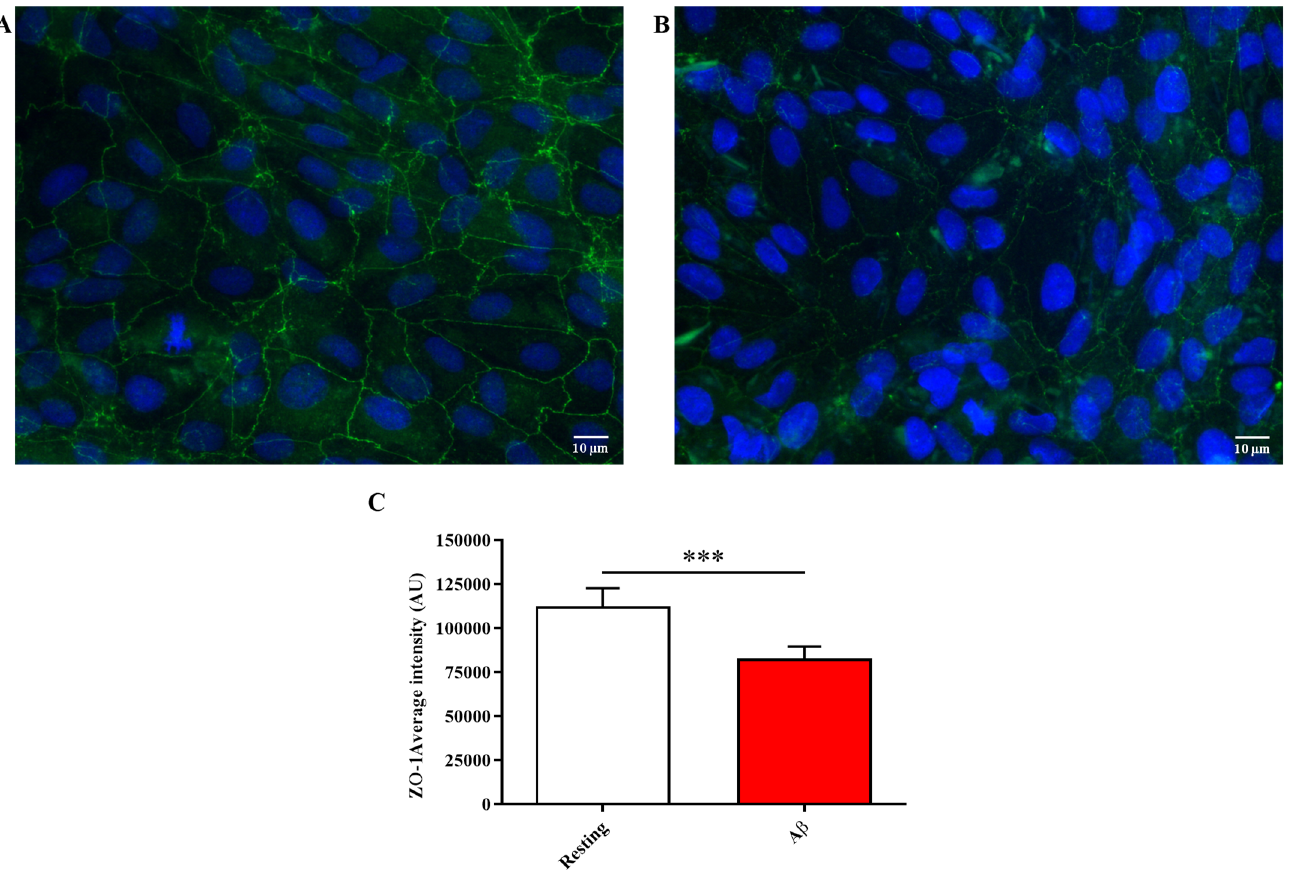
Figure 3. Immunocytochemistry evaluation of ZO-1 staining in ( A ) resting ARPE-19 cells and ( B ) ARPE-19 cells exposed to A β 1-42 oligomers (2 µM) for 48 h. ( C ) The average intensity (AU) of the data from more than 10 values per coverslip for ZO-1 under our experimental conditions is shown. Standard deviations are represented by vertical bars. ZO-1 was labeled with FITC (green), while nuclei were labeled with 4 ′ ,6-diamidino-2-phenylindole (DAPI) (blue). *** significantly different, p < 0.001.